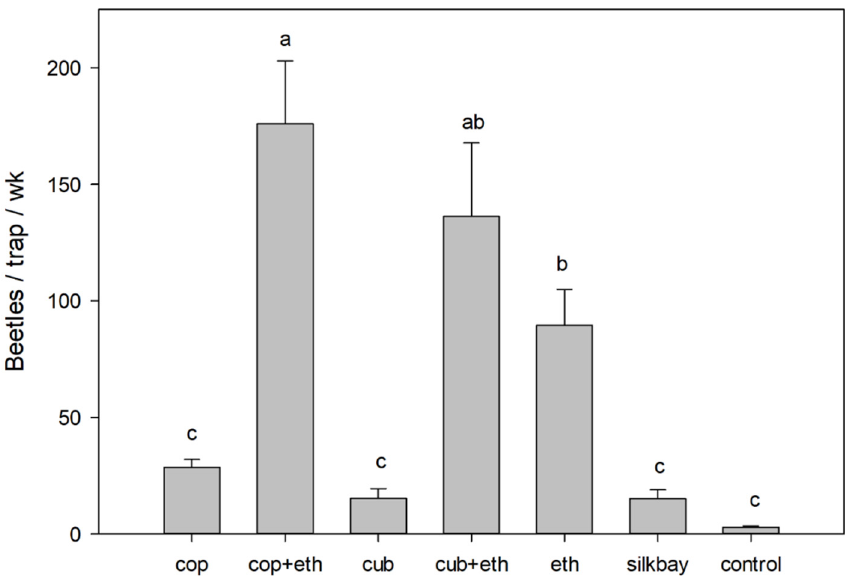
* Species from which Harringtonia lauricola , causal agent of laurel wilt, has been isolated [47]. In the swampbay test (Figure 2), there were significant differences in mean captures of bark and ambrosia beetles (all species combined) among the treatments (F = 28.094; df = 6,28; p < 0.001). Traps baited with α -copaene + ethanol captured the highest number of beetles, and these were significantly higher than captures with ethanol alone. Captures